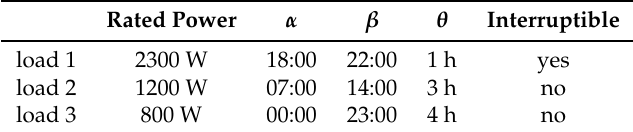
Table 3. Schedulable loads of User 2.